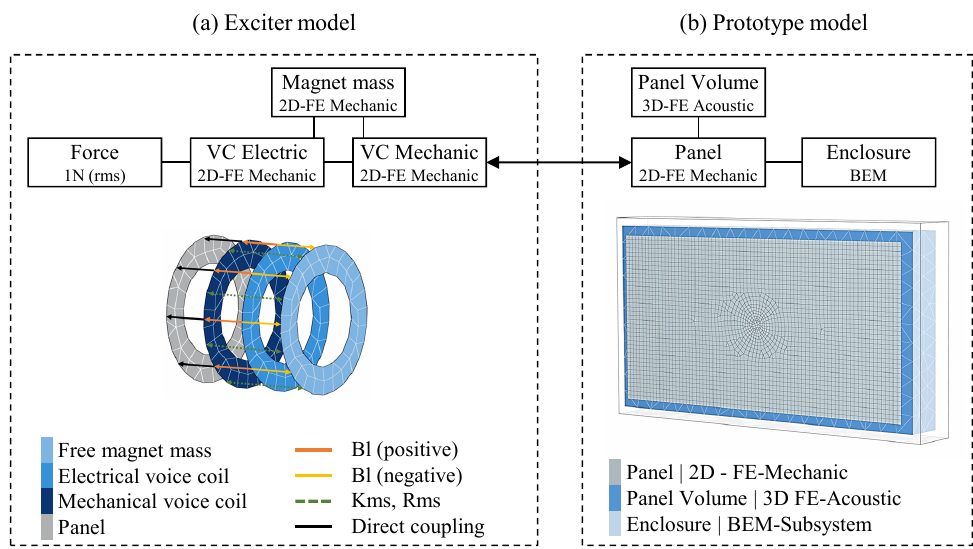
Figure 8. ( a ) Exciter model made up of three subsystems (VC-electric, VC-mechanic and magnet mass); and ( b ) prototype model composed of 2D-FE, 3D-FE acoustic and BEM